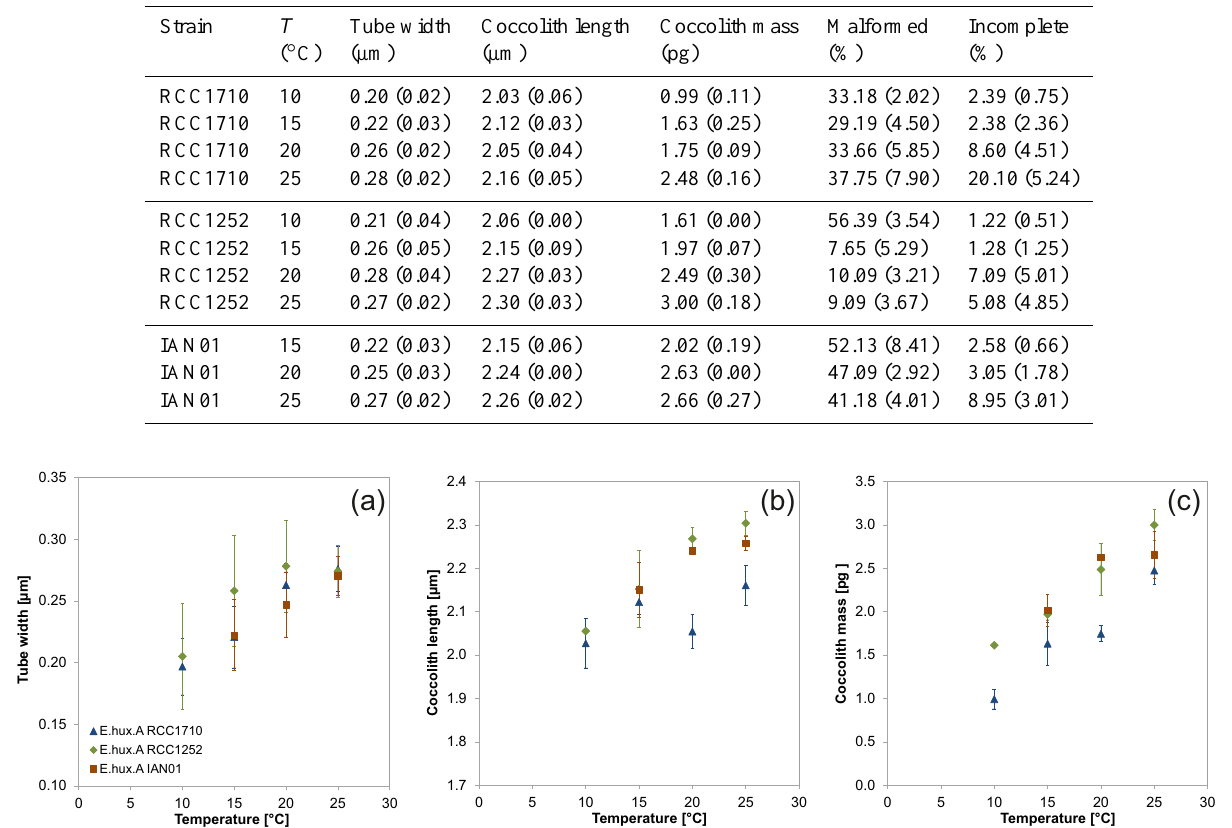
Table 4. Coccoliths morphology and mass. Standard deviation of the triplicates is shown in parentheses.